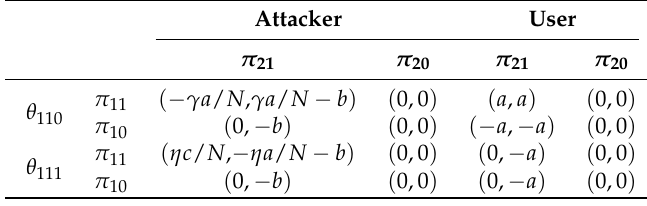
Table 7. The simplified payoff matrix.